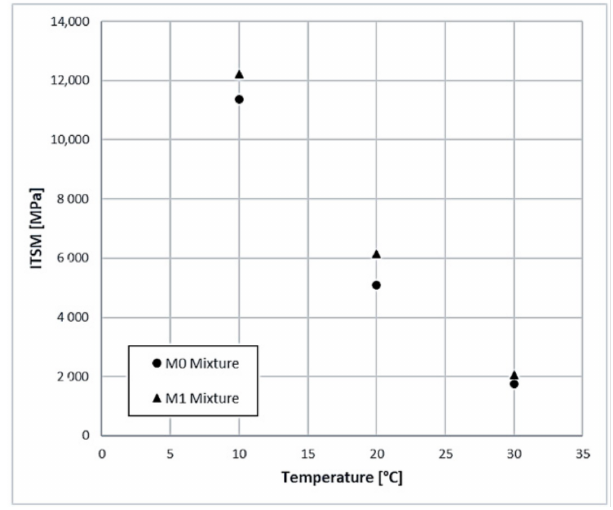
Figure 9. Indirect tensile resilient modulus (ITSM) average value at different temperature (10 ◦ , 20 ◦ , 30 ◦